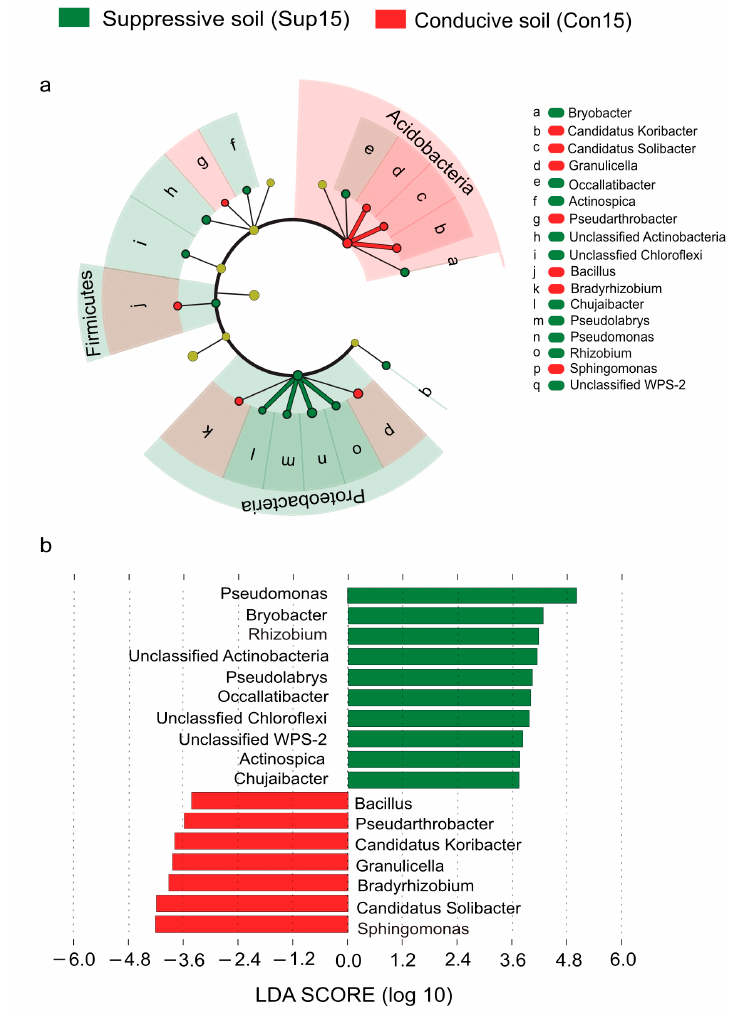
Figure 4. Linear discriminant analysis effect size (LEfSe) analyses of the most differentially abundant (top 30) taxa in the 15-year suppressive and conducive soils. ( a ) Taxonomic cladogram showing the phylogenetic distribution of bacterial lineages. ( b ) Histogram of the linear discriminant analysis (LDA) scores estimated for differential bacterial genera between the suppressive and conducive soils.